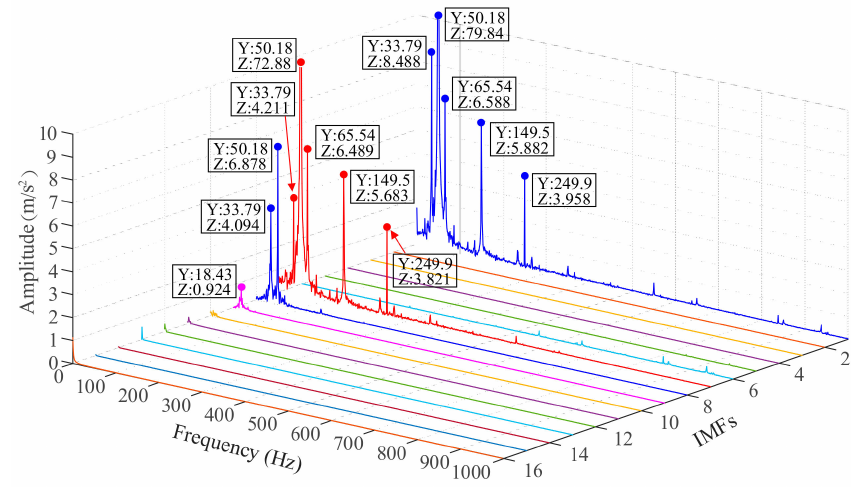
Figure 9. Intrinsic mode functions (IMFs) spectrum of 6mm leakage fault